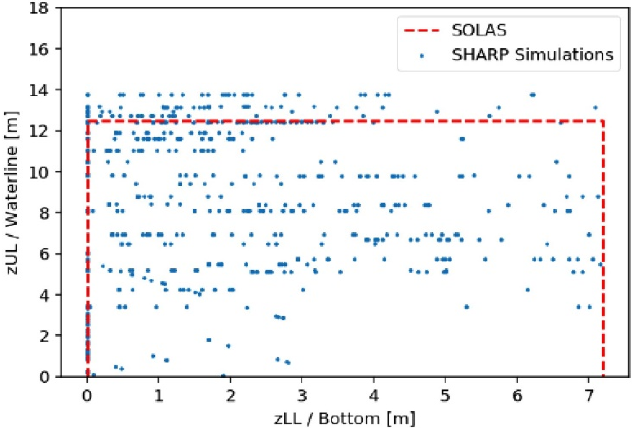
Figure 21. Damage vertical position upper limit versus lower limit for simulated damages .